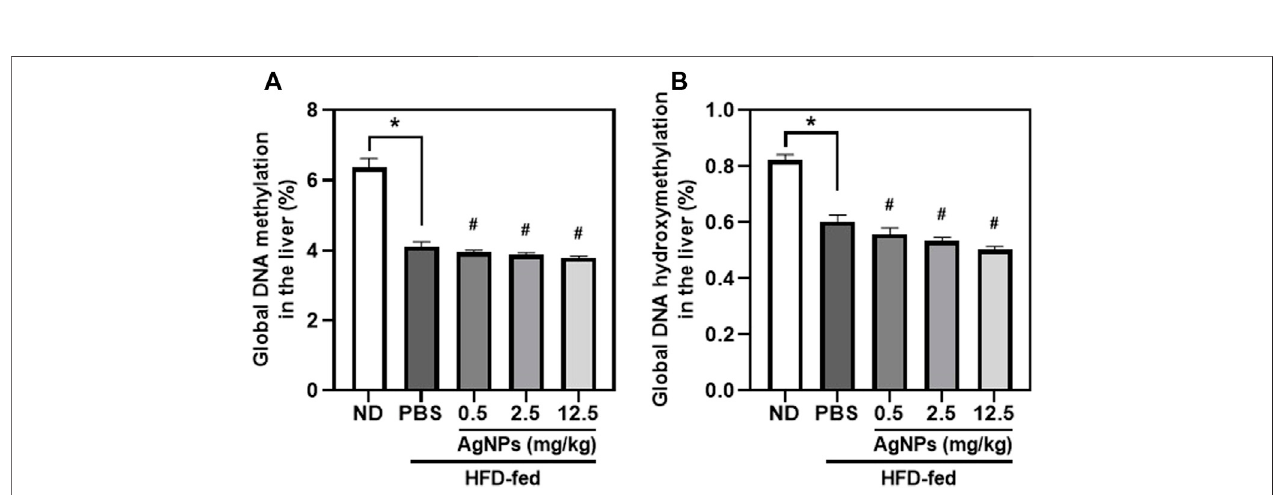
FIGURE6| Epigenetic changesinducedbyAgNPs intheliver ofHFD-fed miceAgNPs furtherlydecreasedthepercentageofglobal DNA methylation (A) and DNA hydroxymethylation (B) in the liver of NAFLD mice induced by HFD. * p < 0.05 vs. ND-fed group; # p < 0.05 vs. HFD-treated group.